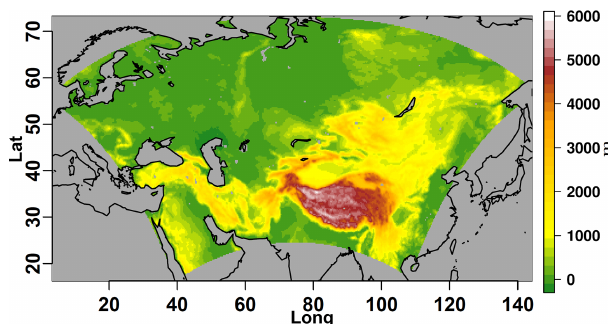
Figure 1. Orography map of the Central Asia simulation domain at a spatial resolution of 0.22 ◦ . Terrain height information is derived from the Global Land One-kilometer Base Elevation (GLOBE; GLOBE Task Team and others, 1999) data